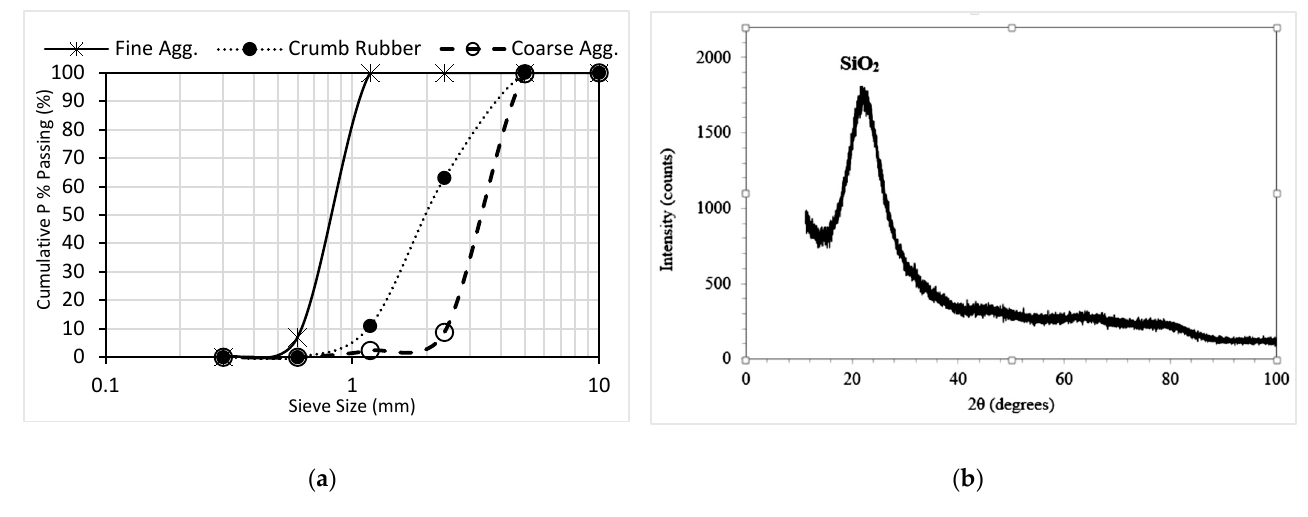
Figure 1. ( a ) Grading of aggregates and CR; ( b ) XRD pattern of nanosilica. Table 1. Physical properties of aggregates and CR.